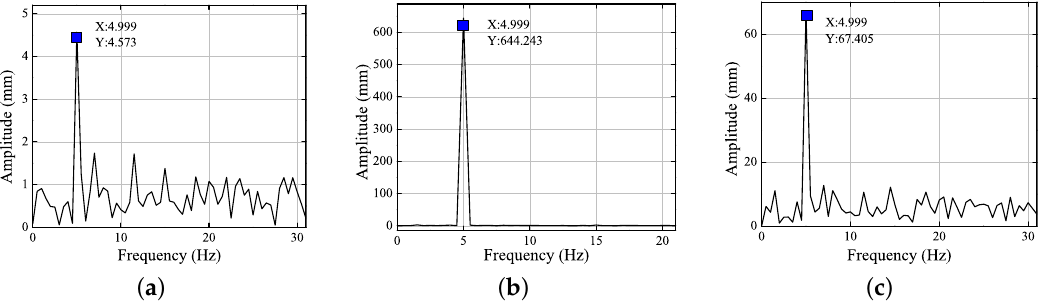
Figure 5. Frequency spectra of the left eye in the ( a ) X , ( b ) Y , and ( c ) Z